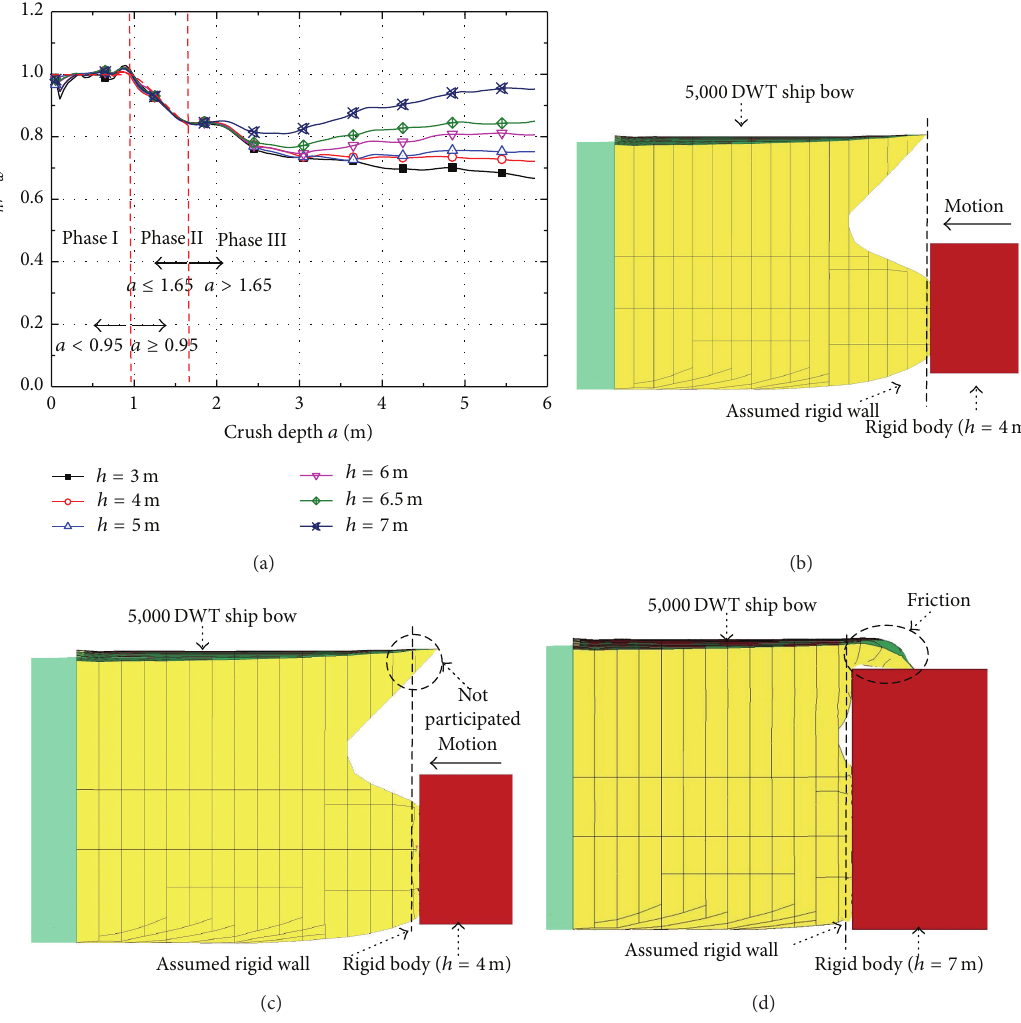
Figure 11: 𝐸 ℎ /𝐸 𝑤 value and contact condition at different phases: (a) 𝐸 ℎ /𝐸 𝑤 for all of pile-cap depths; (b) contact condition at Phase I; (c) contact condition at Phase II; (d) contact condition at Phase